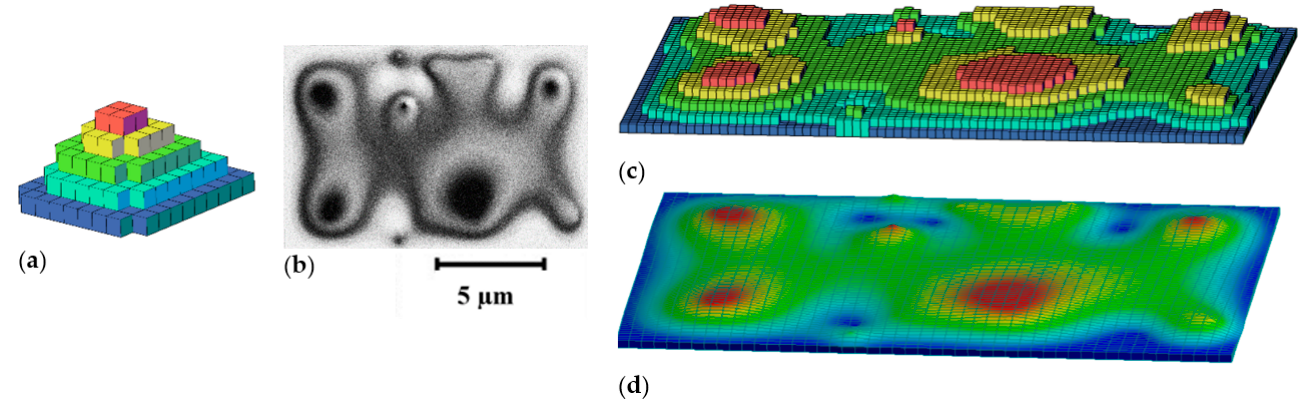
Figure 5. Roughness evaluation from a black and white pixel SEM image: ( a ) logic of voxel stacking; ( b ) 750 × 500 black and white pixel image example; ( c ) 3D voxel roughness modeling; ( d ) 3D NURBS roughness modeling. Table 3. Minimum, maximum, and medium values obtained with the complexity GP prediction model.